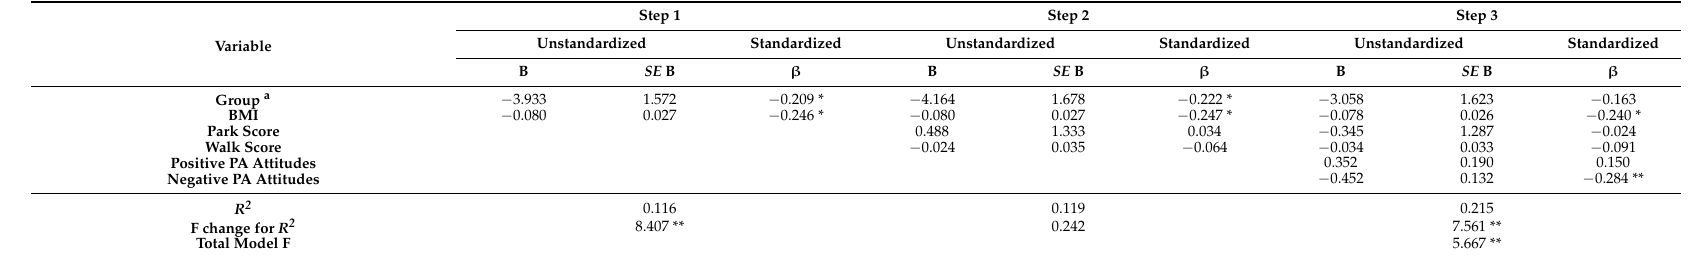
Table 5. Multiple regression model of sit-to-stand test.